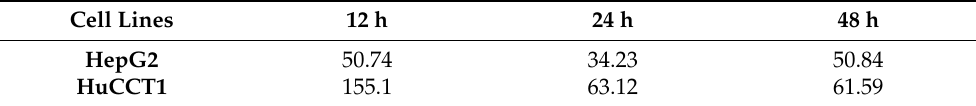
Table 3. The IC 50 values of TQ in different cell lines after 12, 24, and 48 h of treatment. Cell